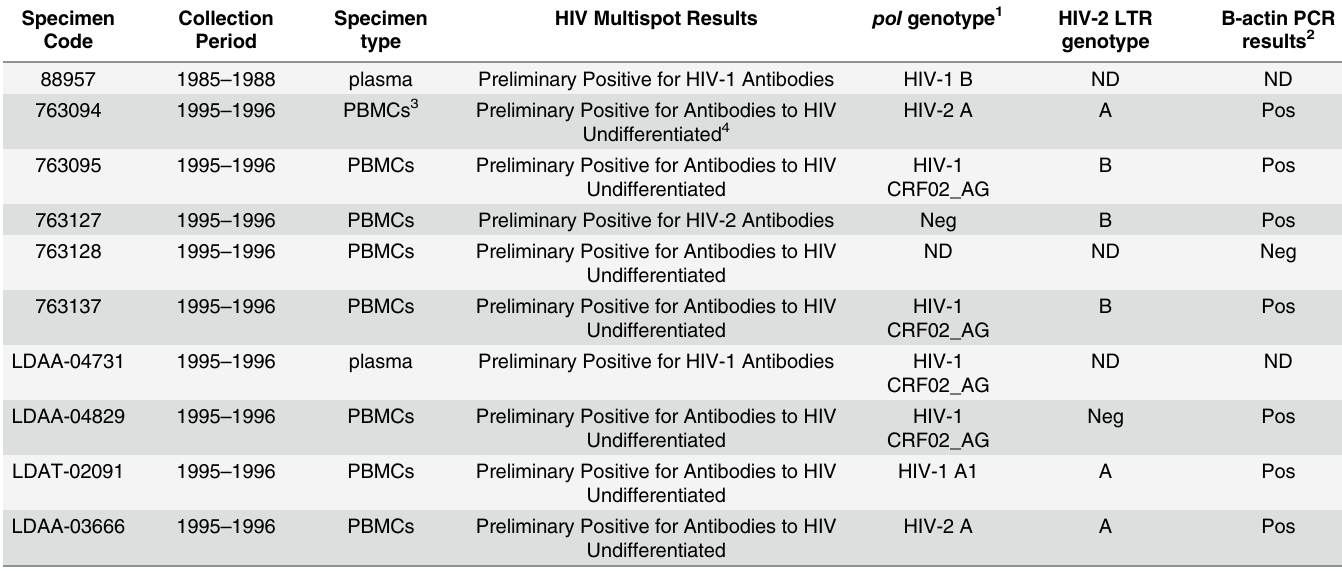
Table 2. Detection of HIV dual infections in Côte d ’ Ivoire 1985 –